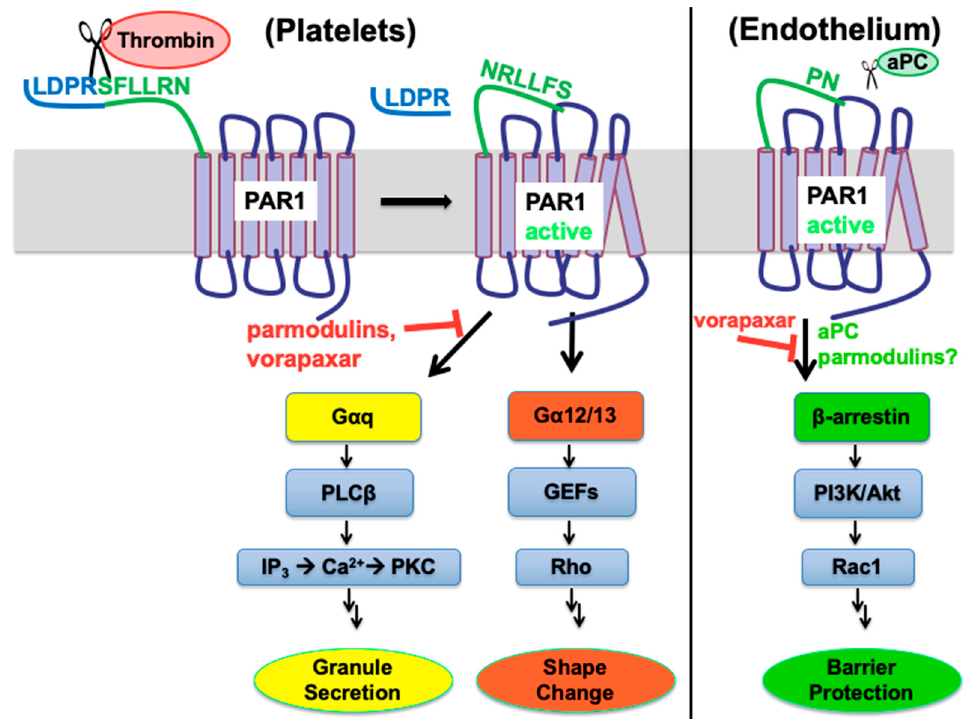
Figure 4. Abbreviated PAR1 signaling diagram. In platelets (left), cleavage of the N-terminus of PAR1 by thrombin at Arg41 leads to platelet shape change and granule secretion. These processes can be blocked by PAR1 antagonists such as vorapaxar and by parmodulins to varying degrees. In endothelial cells (right), activated protein C (aPC) can cleave PAR1 at Arg46, giving a barrier-protective signal via β -arrestin-2.